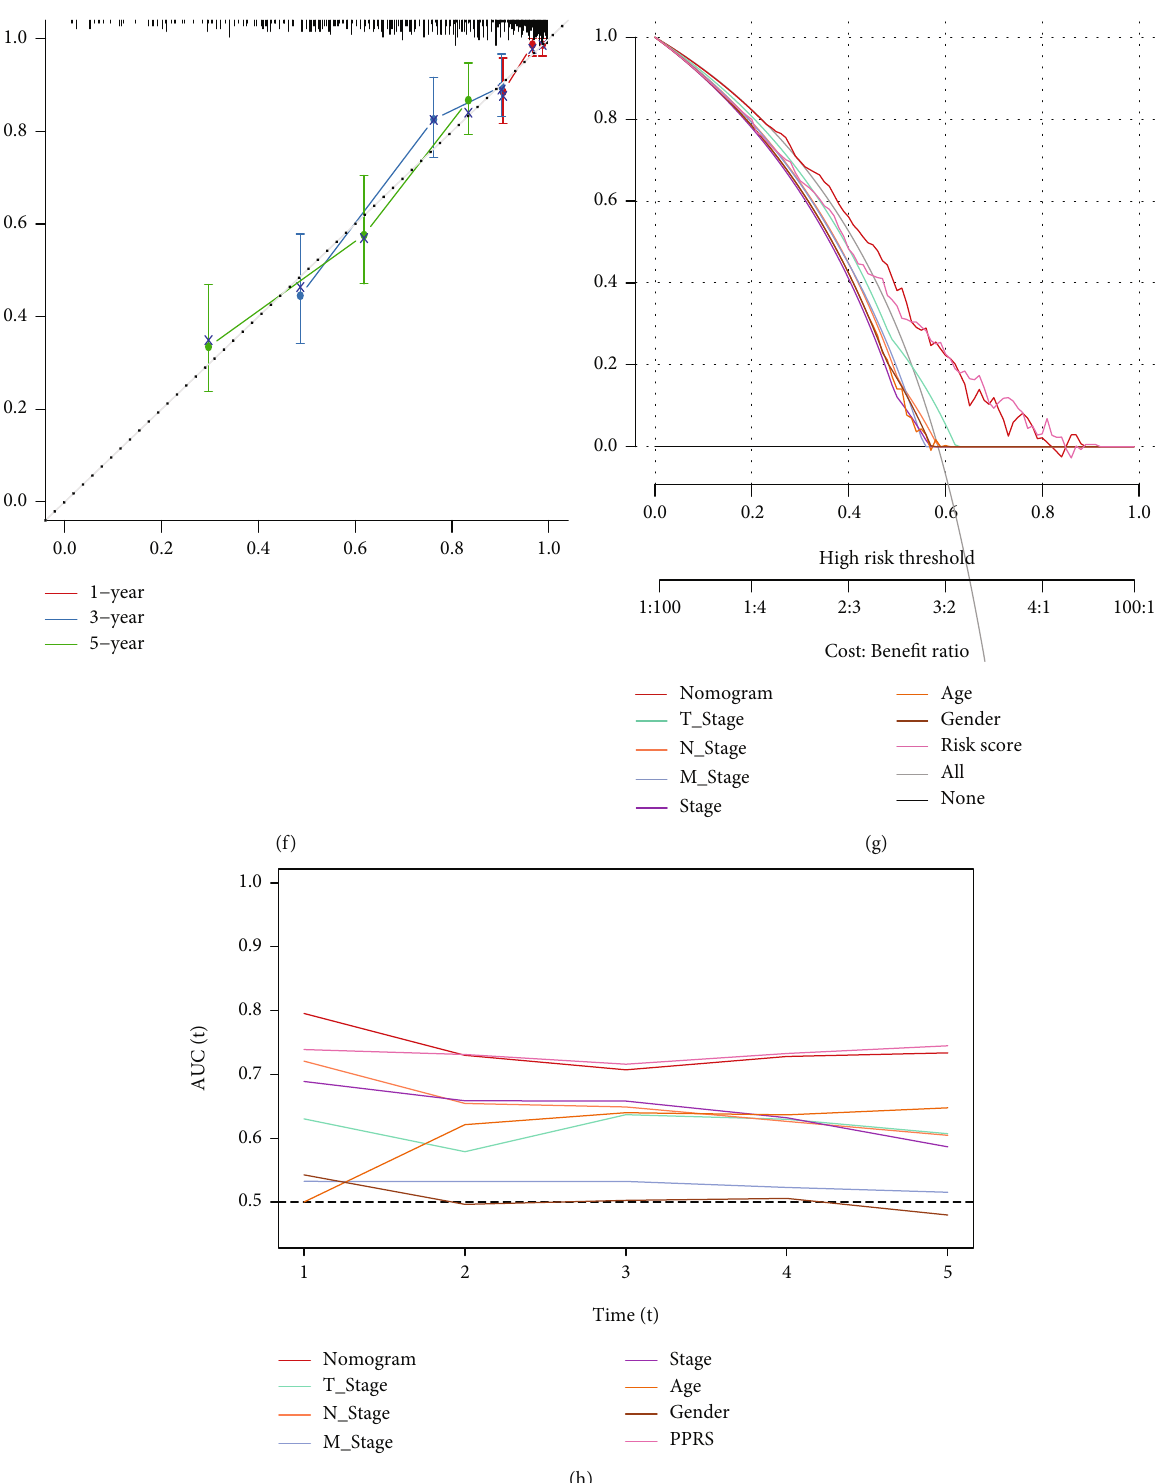
Figure 11: The nomogram and survival decision tree were produced for improving risk strati fi cation and predicting the survival probability. (a) Cases who had complete annotations such as T stage, N stage, PPRS, and age were applied in constructing the survival decision tree for optimizing risk strati fi cation. (b – d) Di ff erences in OS (b), PPRS scores (c), and living states (d) were signi fi cant across the 6 risk groups. (e) Detailed information of the nomogram. (f) Our constructed PPRS and nomogram were highly accurate based on calibration analysis. (g) Decision-making curve of the nomogram. (h) Relative to additional clinicopathological factors, our as-constructed PPRS and nomogram performed well in predicting